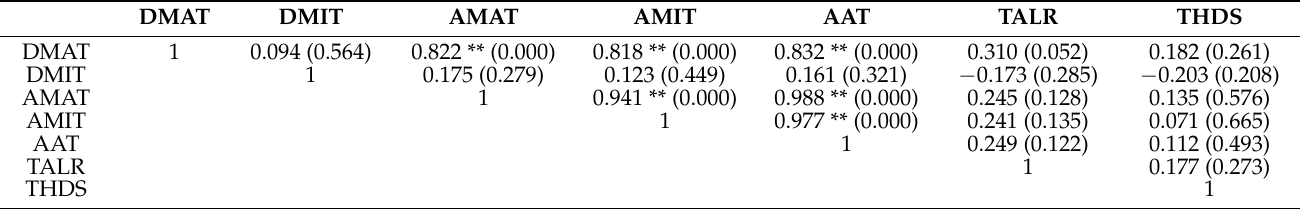
Table 6. Pearson correlation analysis of extreme weather and climate change for